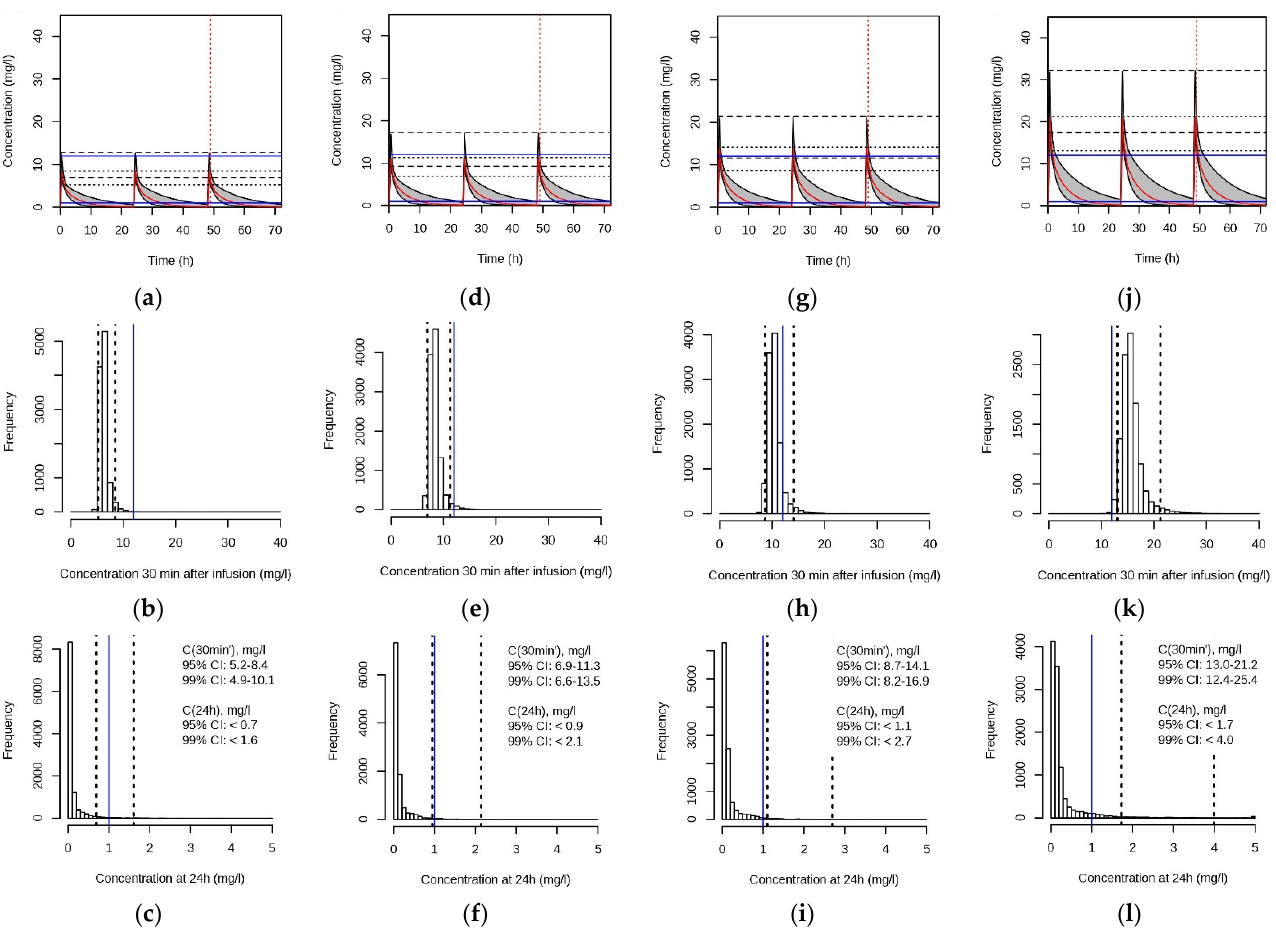
Figure 7. Simulations with the final model over 3 dosing intervals of 24 h each with 30 min infusion time. Once daily dose was ( a – c ) 3 mg/kg; ( d – f ) 4 mg/kg; ( g – i ) 5 mg/kg; ( j – l ) 7.5 mg/kg. ( a , d , g , j ) Simulated plasma-concentration time curves. ( b , e , h , k ) Respective distributions of simulated C (30 min’) of the third infusion. ( c , f , i , l ) Distributions of the simulated C (24 h’) of the third infusion. For further details, see Figure 6.